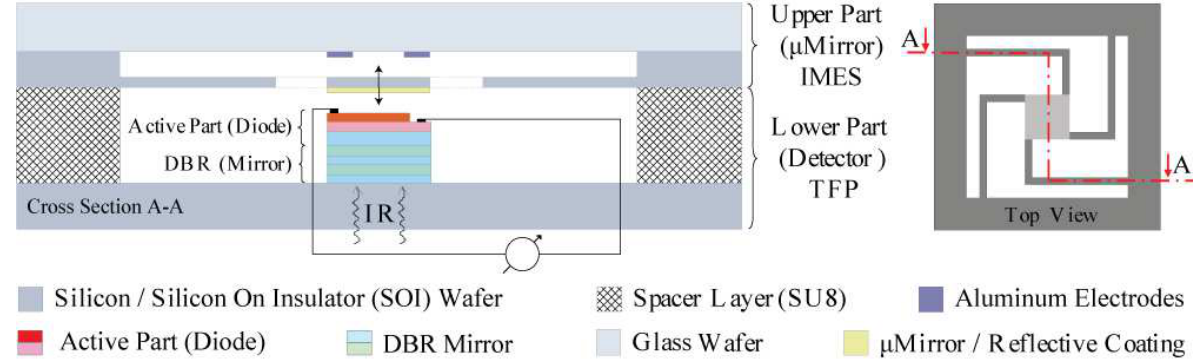
Figure 1: Tunable RCED working principle. Left: cross section with micromirror (upper part) and detector (lower part). Right: top view showing micromirror and mirror